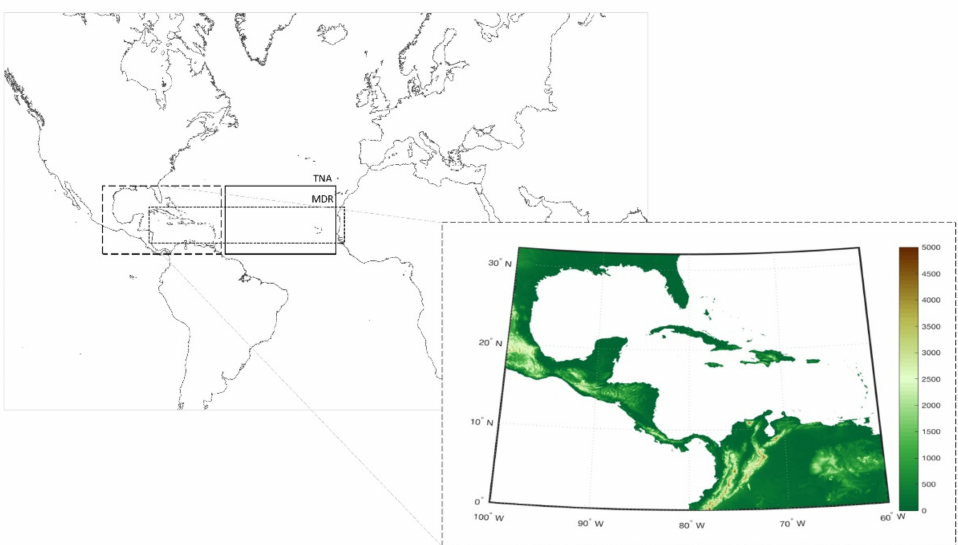
Figure 1. Map depicting the extent of the Caribbean and surrounding region domain of inter- est (5 ◦ –31 ◦ N, 100 ◦ W–55 ◦ W) with color contours depicting the elevations (in meters), the Main Developing Region (10 ◦ N–20 ◦ N, 20 ◦ W–80 ◦ W), and the Tropical North Atlantic (0 ◦ N–40 ◦ N, 10 ◦ W–100 ◦